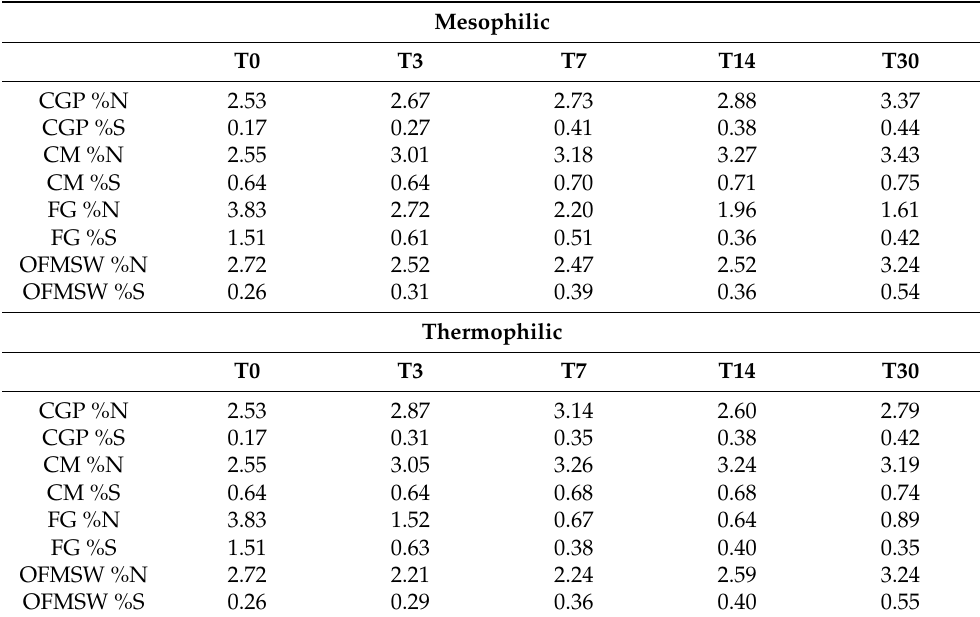
Table 6. Mean values for N and S concentrations in percent of total feedstock measured by elemental analysis at different time points (0, 3, 7, 14 and 30